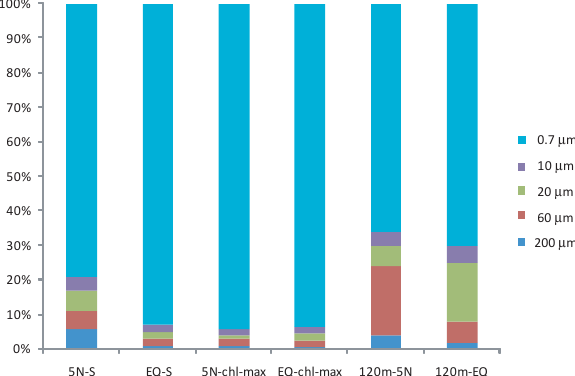
Fig. 13. Size fractionated phytoplankton biomass (mgChl a m − 3 ) in percentage during August 2006 at 5 ◦ N and equator along 77 ◦ E from surface, chlorophyll maximum and at